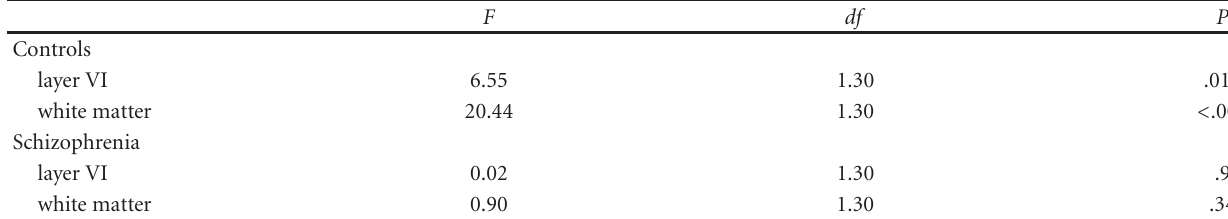
Figure 1: Plots summarizing results of regression analysis in BA9. There is a significant positive correlation between Nv of oligodendrocytes and age in controls in layer VI ( P = . 007) (a) and in adjacent white matter ( P = . 03) (b) but no significant correlations in schizophrenia, bipolar disorder, and major depression. Table 4: Regression of Nv of oligodendrocytes on age in